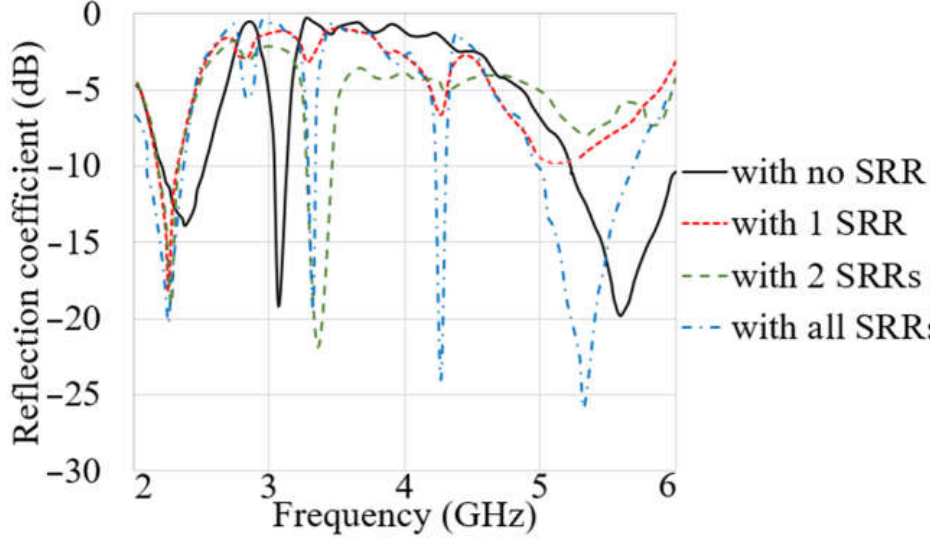
Figure 3. The surface current distribution of the button spiral antenna ( a , b ): no loadings at 3.4 GHz and 5.6 GHz; ( c , d ): after adding three rings at 3.4 GHz and 5.6 GHz; ( e , f ): after adding vias at 3.4 GHz and 5.6 GHz).